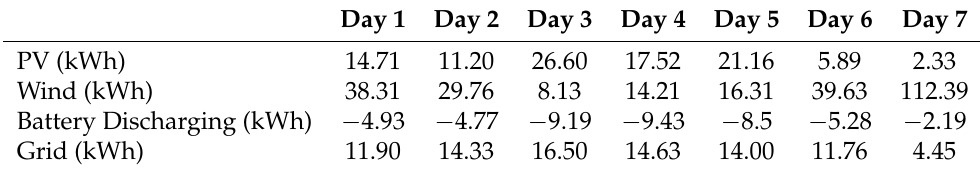
Table 4. Production sources used for every day of the week after applying the model.